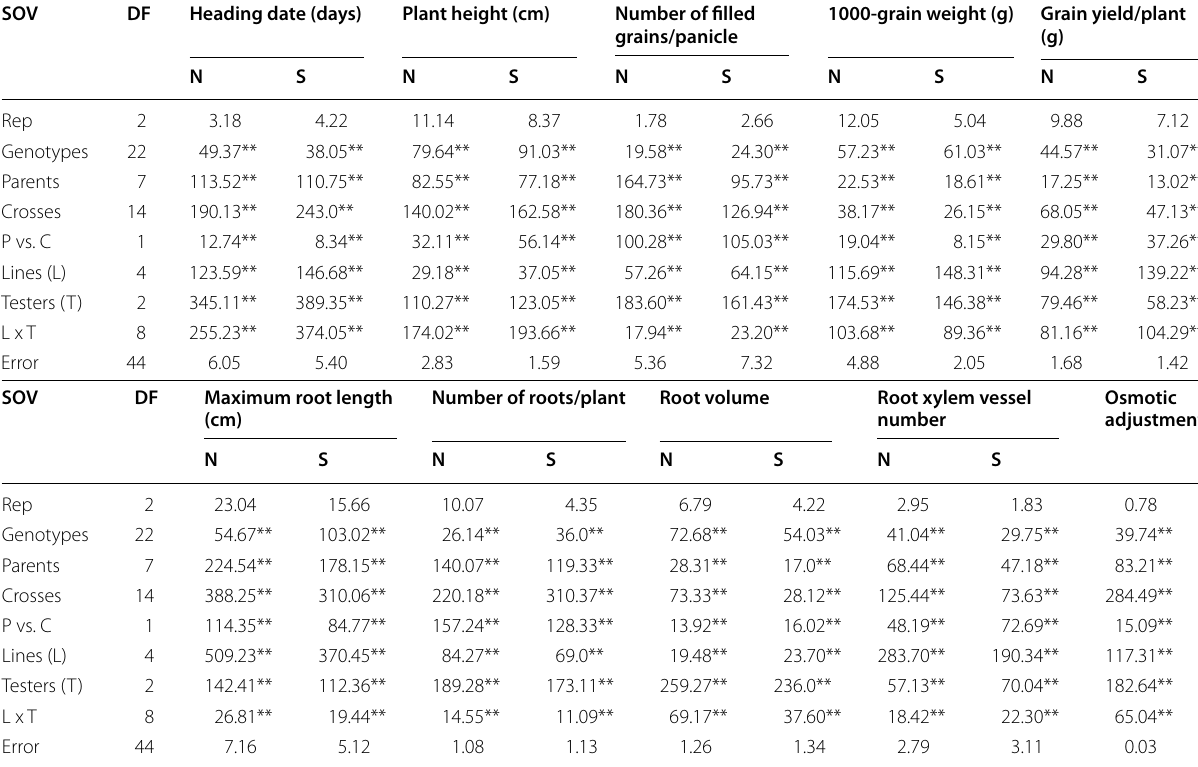
N: normal and S: stress